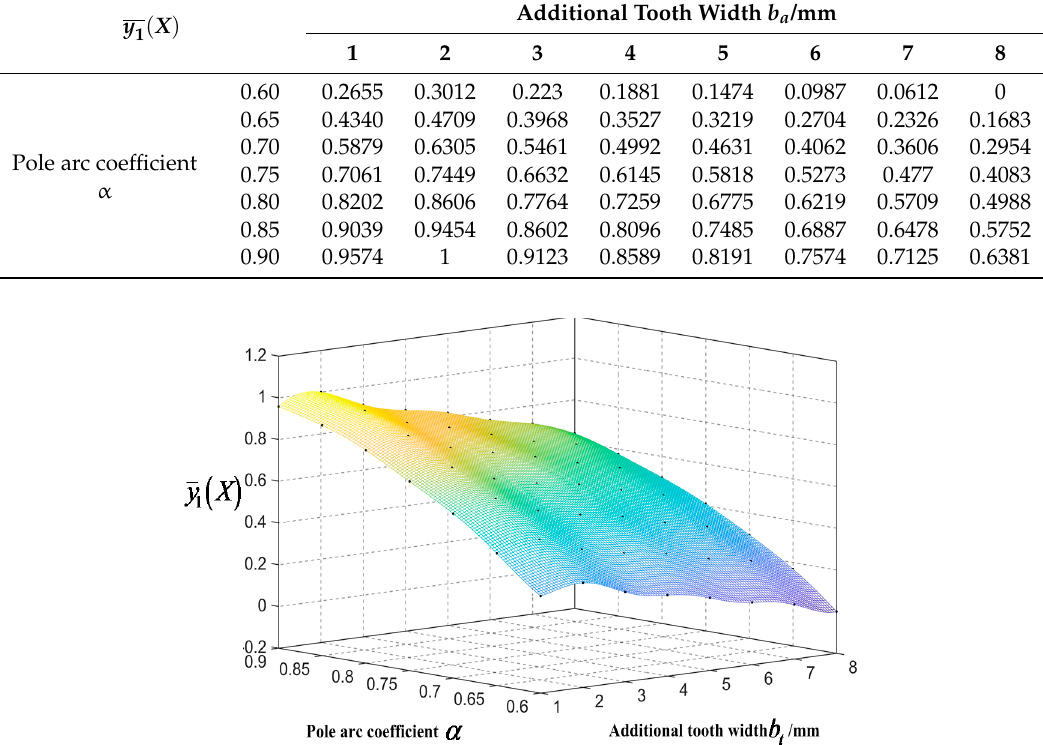
Table 3. Normalized objective value y 1 ( X ) .